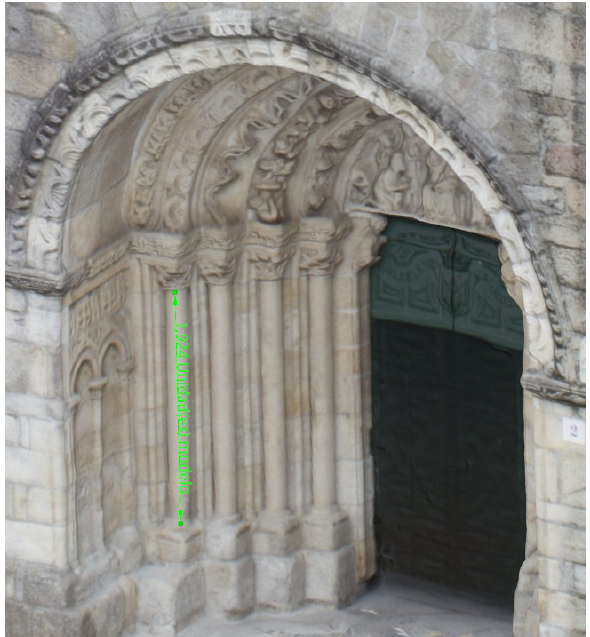
On the other hand, the model could be exported from “Agisoft PhotoScan Pro” to “Adobe PDF 3D” file which allows everybody to explore the model through zoom, rotate and move functions, as well as to get measurements directly from the model (that was exported in a properly scale).